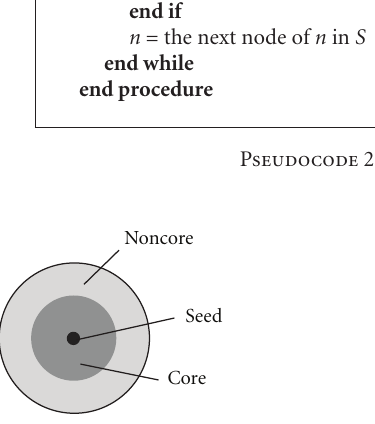
Figure 2: The illustration of a typical cluster with densely con- nected core and less densely connected